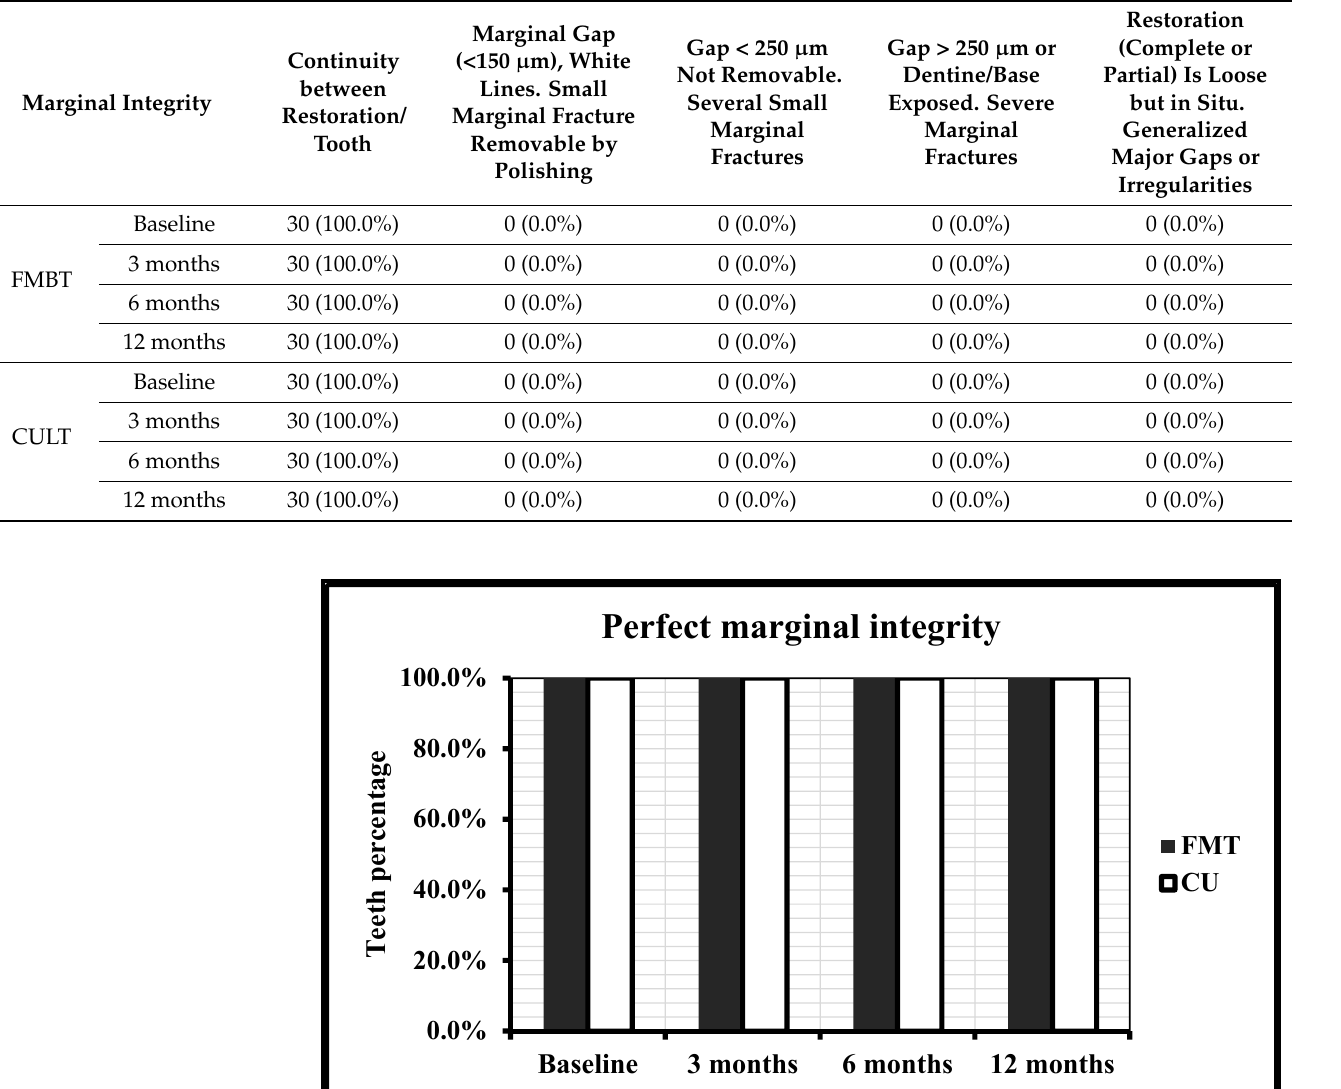
Table 7. Marginal adaptation of teeth restored with FMBT and CULT over time ( p > 0.05).